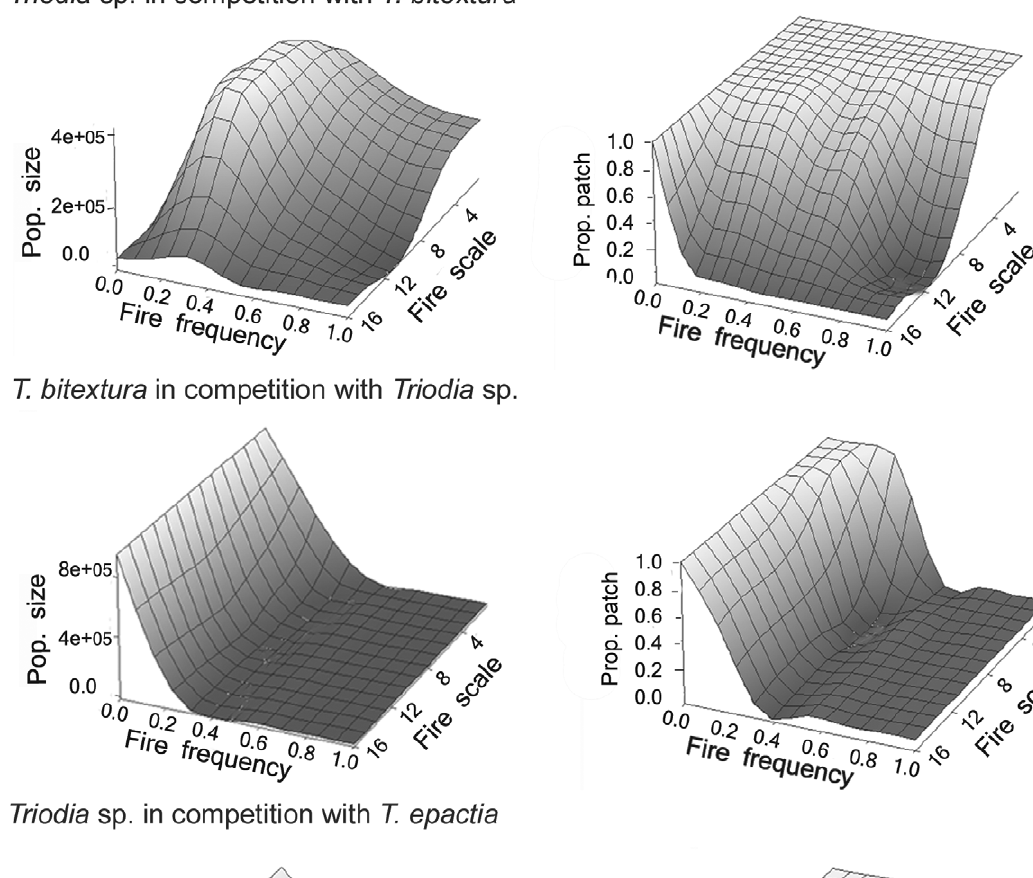
Figure 2. The mean population size and proportion of patches occupied at different fire frequencies and scales over the entire ‘landscape’ when two species are in competition.